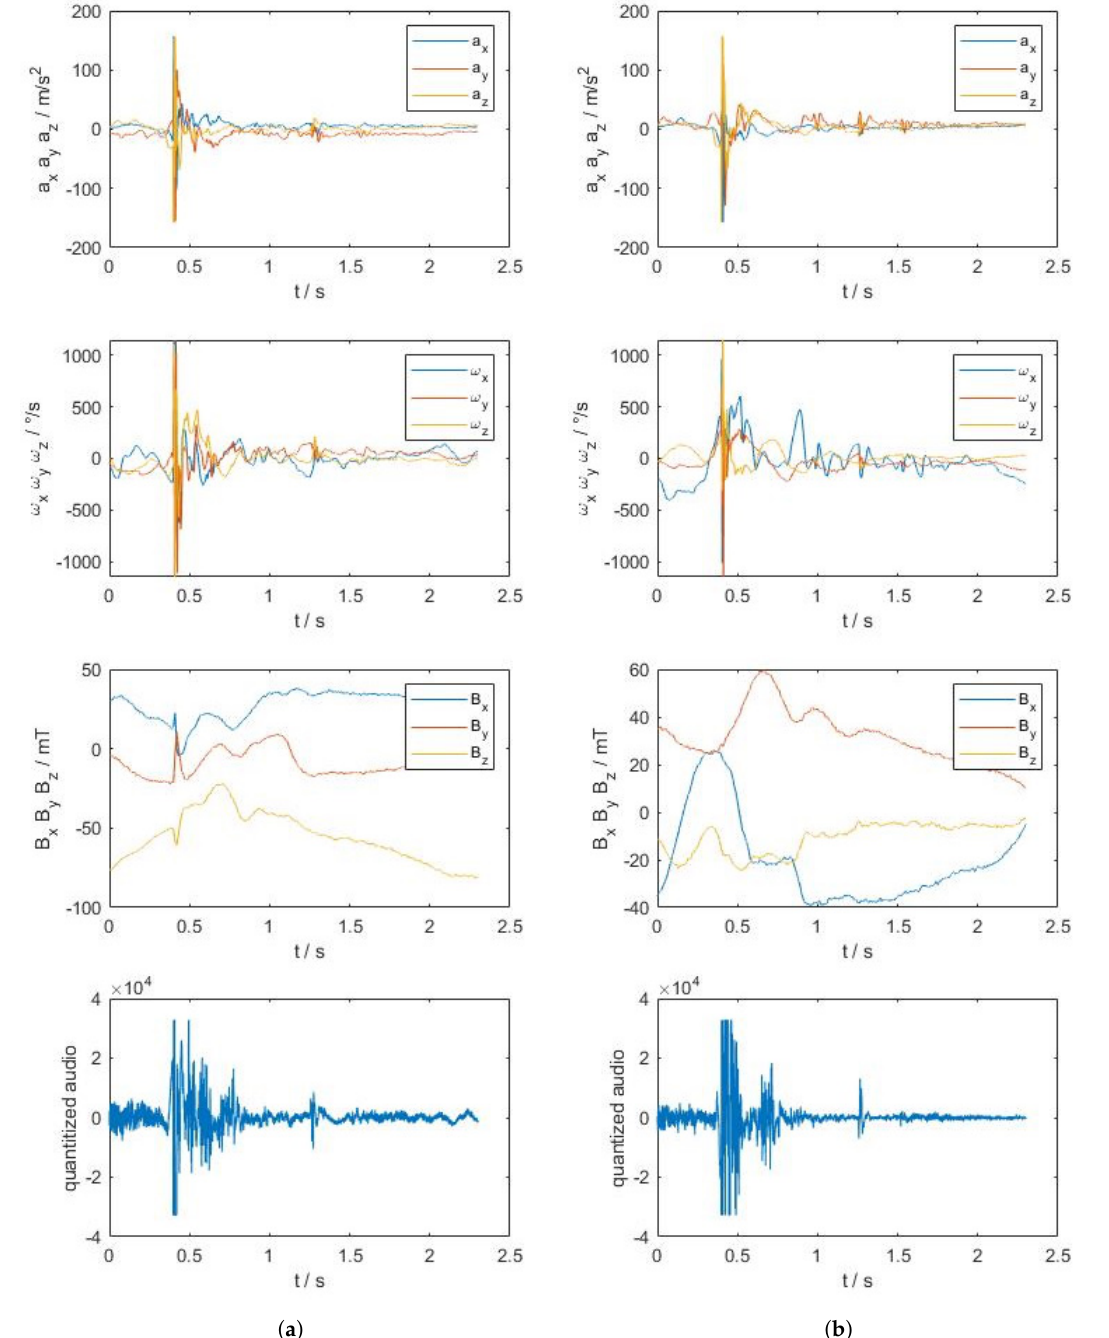
Figure 4. Raw signals (acceleration a in all axis, spin rate ω around all axis, flux density B in all axis and quantized audio) of the left ( a ) and right ( b ) hand for a caught pass under the circumstances: automated passing machine [31], standing, facing towards, twohanded, advanced, indoor, Prototype